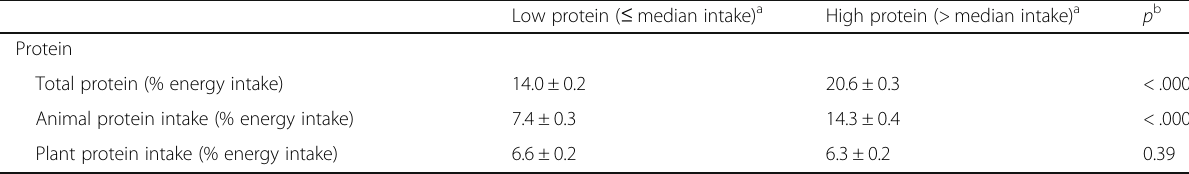
Table 4 Macronutrient intake in high- and low-protein consumers stratified by ethnicity (Continued)